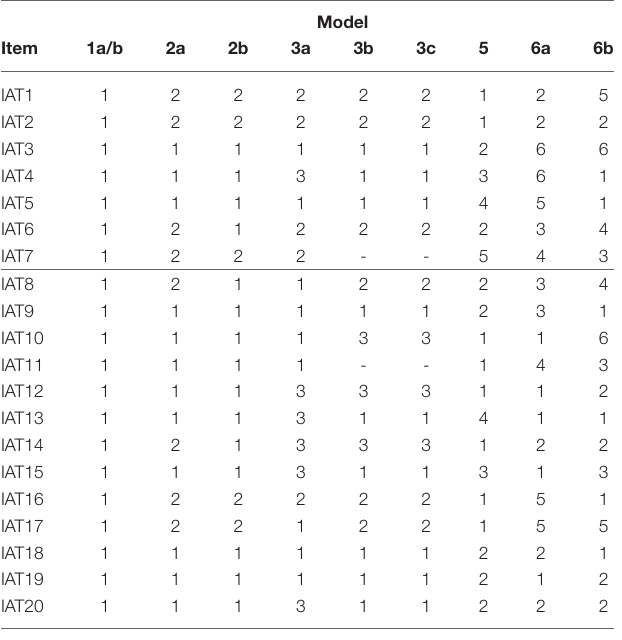
TABLE 4 | Factor structure of IAT in the prior research.